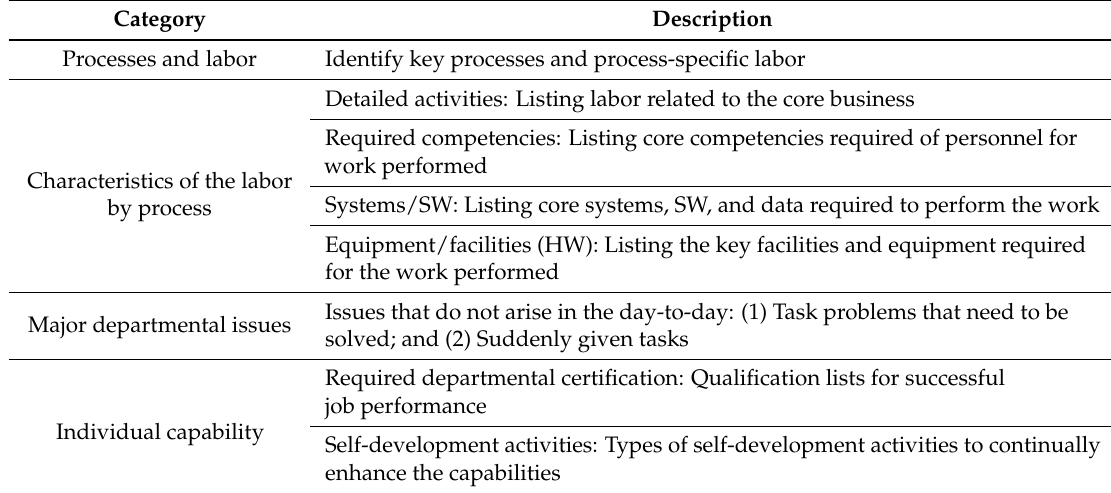
Table 7. Preliminary evaluation entries for the individual and organizational competitiveness.